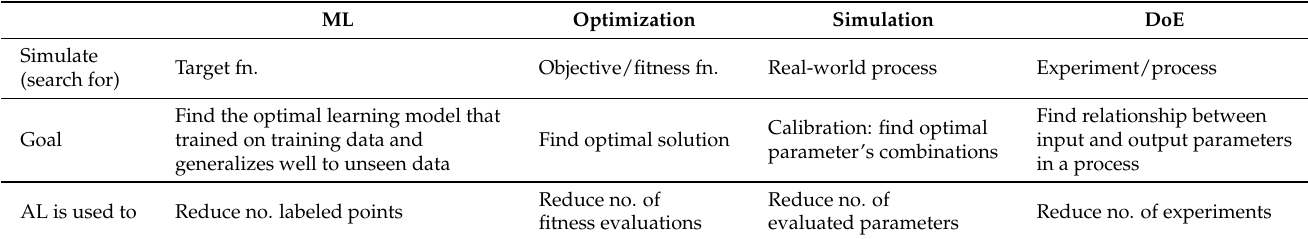
Table 3. Comparison between different research directions and how AL could be used to assist each of